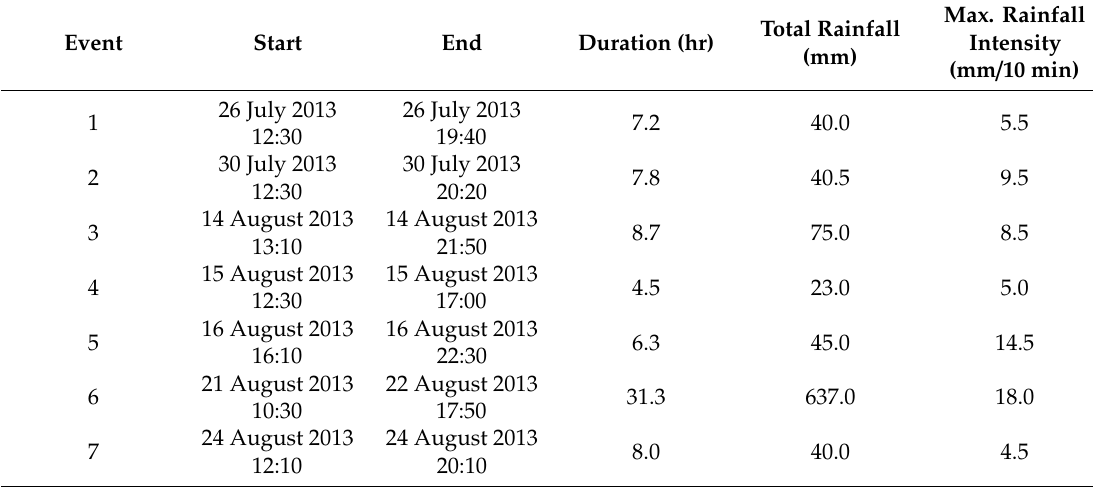
Table 2. Properties of the e ff ective rainfall